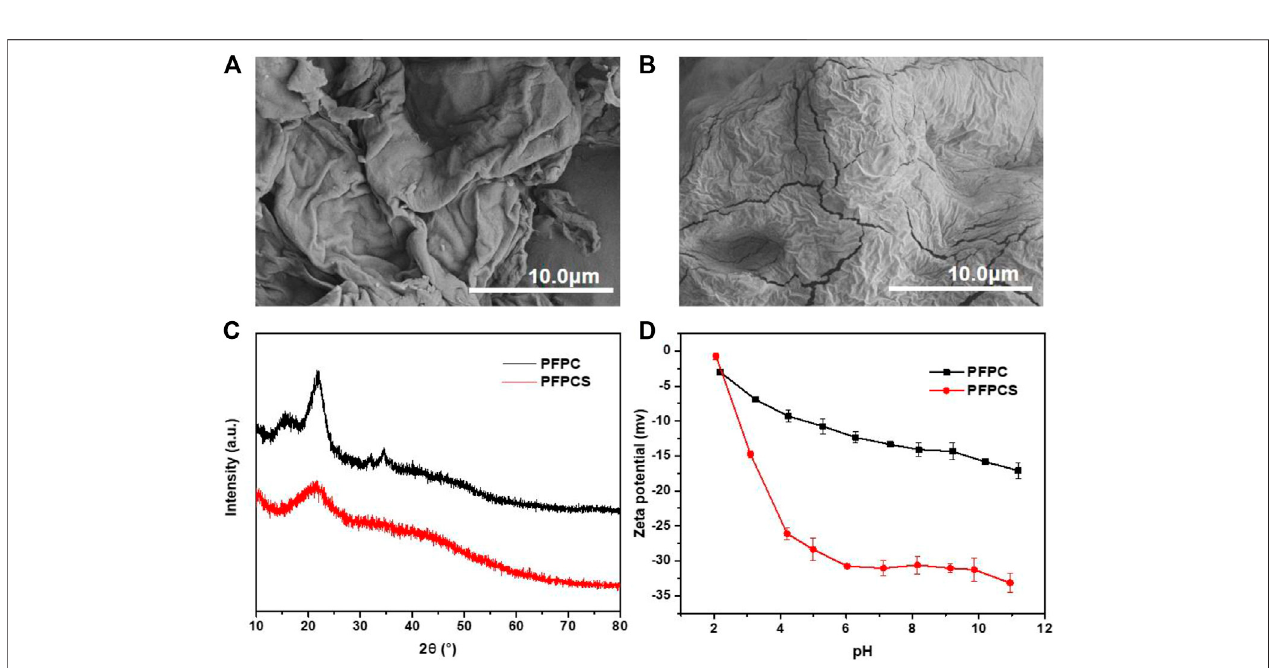
Frontiers in Chemistry |